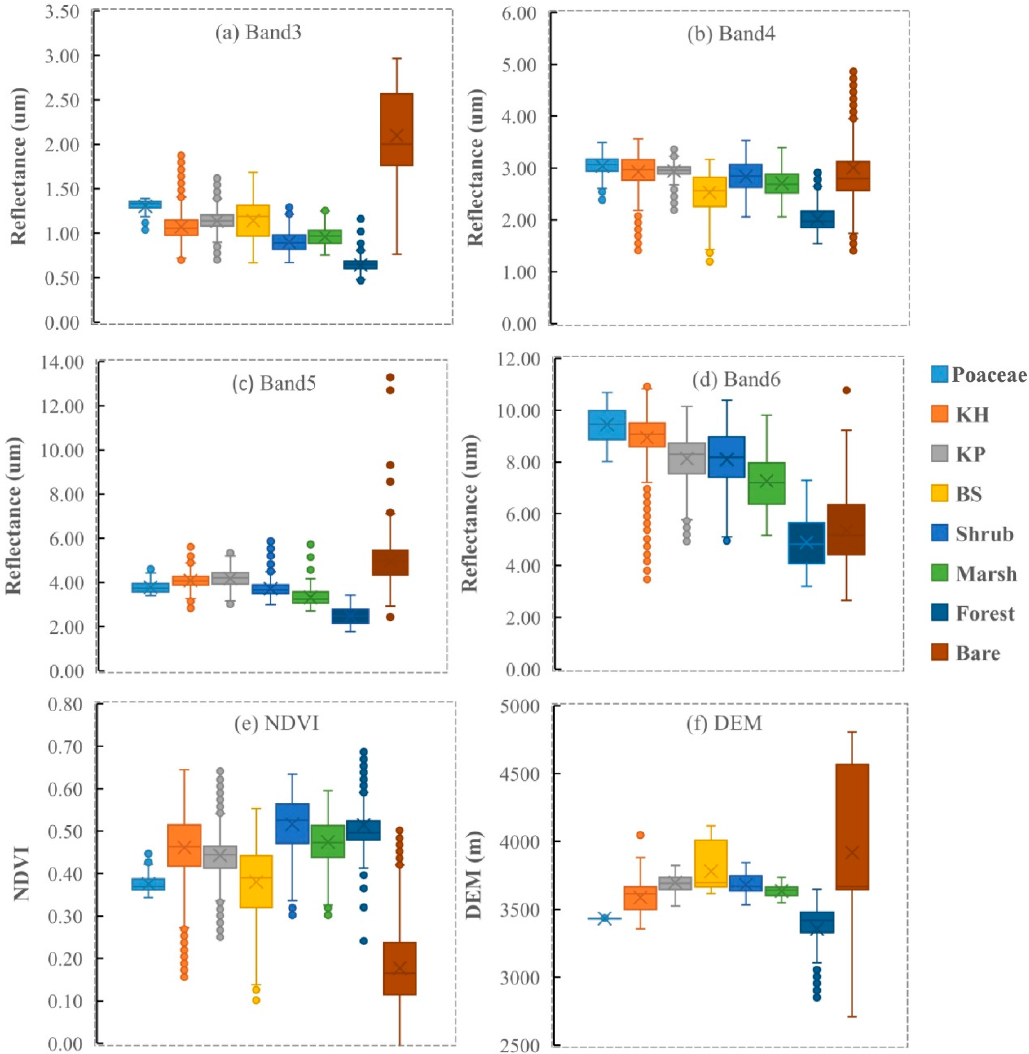
Figure 4. Statistical analysis results of band3 to band6 of GF1/GF6 images ( a – d ), NDVI ( e ) and DEM ( f ), respectively; Poaceae, KH, KP and BS represent Elymus nutans + Stipa silena + Festuca ovina , Kobresia humilis , Kobresia pygmaea and black soil type, respectively.